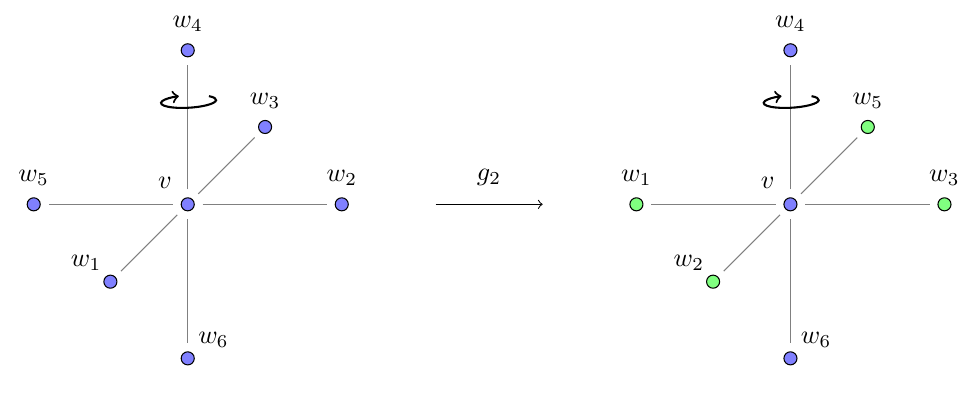
Figure 10 . The reduced state (cid:26) vw 1 :::w 6 on the 3-dimensional square lattice transforms under a rotation about the marked axis in a way that maps the label w v (cid:12)xed. Vertices that are altered by this symmetry transformation are marked in green in the second image. The existence of such a symmetry implies that the two-party reduced states satisfy (cid:26) vw 1 = (cid:26) vw 2 : This rotation is just one choice of symmetry g 2 ; other lattice symmetries can also map w 1 to w 2 while di(cid:11)ering in how they permute the other neighbors w i